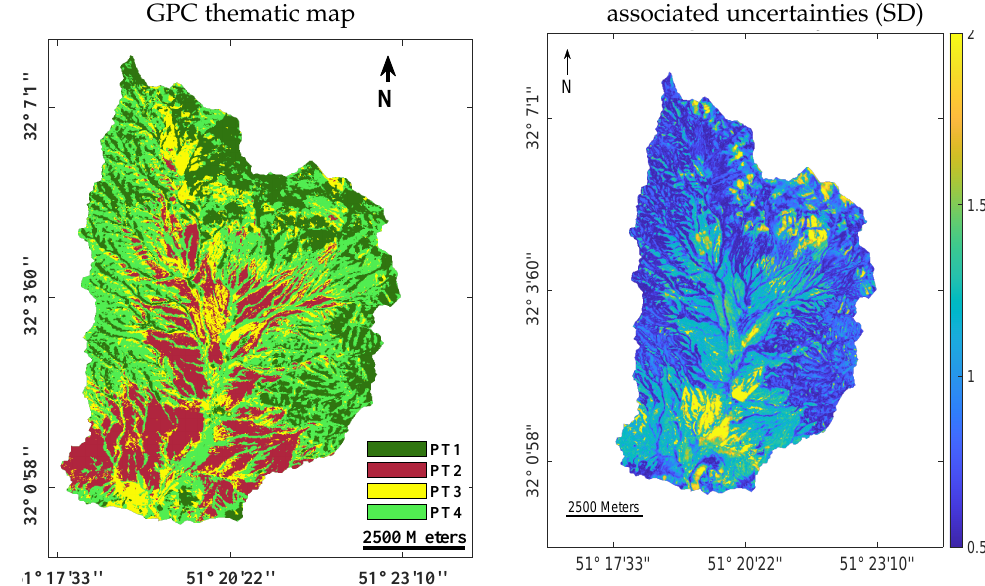
Figure 6. Left : thematic map of PTs as obtained from the top-performing Gaussian process classifier (GPC). Right : Associated uncertainty map as expressed by standard deviation. The higher the value, the more